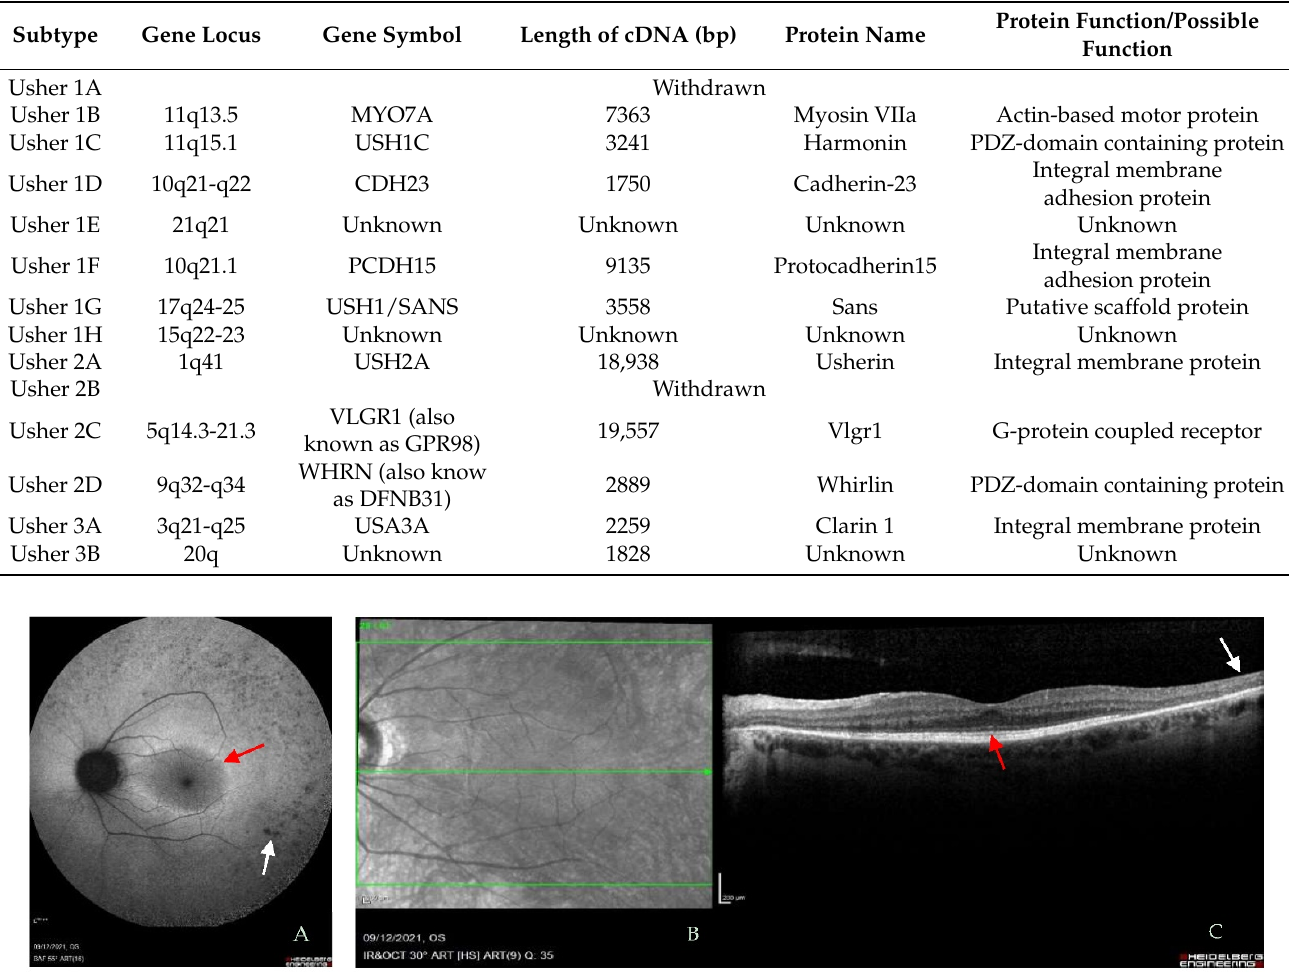
Figure 1. Example images of a patient with Usher ( USH2A ) syndrome. ( A ) Autofluorescence images show a ring of hypo-autofluorescence (red arrow) around the macula, a classic presentation of ciliopathy. The peripheral retina shows pigmentary changes (white arrow). The ring indicates loss of the photoreceptor outer segments and outside of the ring there is loss of rod photoreceptor cells. ( B ) Optical coherence tomography (OCT) images from the same patient showing an optical section through the retina (Central green arrow indicates position of horizontal section). ( C ) There is thinning of the peripheral retina (white arrow) and some loss of the outer segments. Intact outer segments are indicated by the red arrow. Scale bar 200µm. Images from Oxford Eye Hospital, Oxford University Hospitals NHS Foundation Trust, Table 1. Usher syndrome subtypes, genes and proteins. https://www.institut-vision.org/en/28-dis- eases/91-usher-syndrom.html (accessed on 28 August 2022).